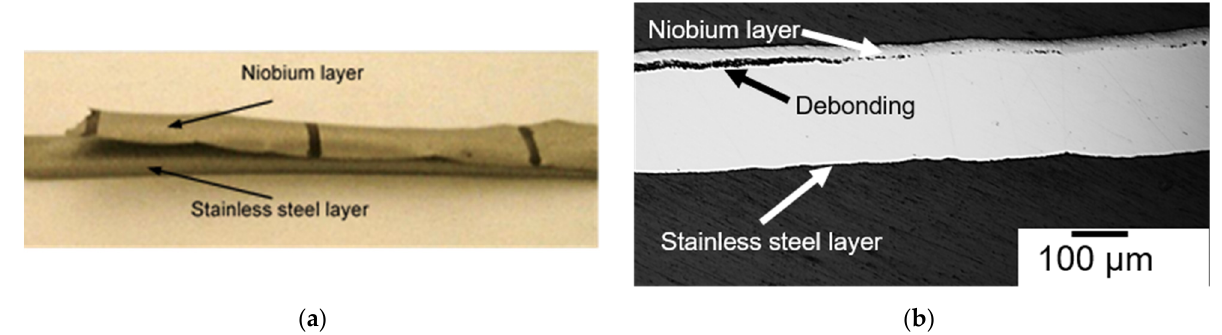
Figure 10. Debonding under tensile loading of niobium clad stainless-steel specimen as shown in ( a ) the optical image of the specimen, and ( b ) the optical micrograph of the cross-section along the specimen length.